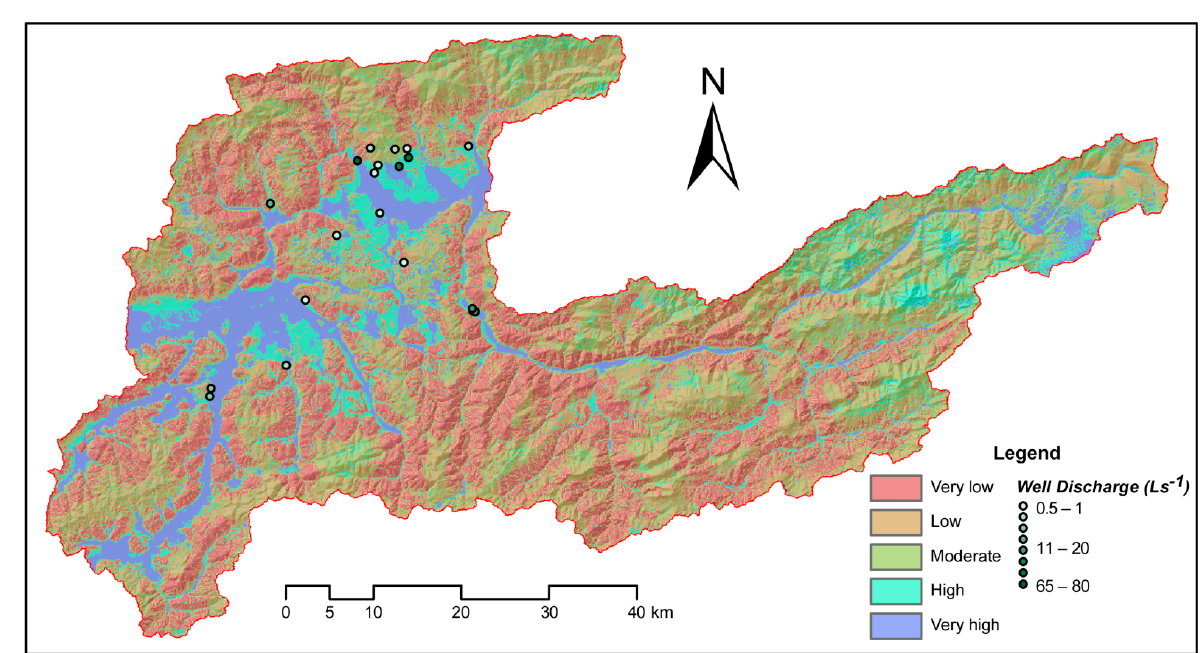
Figure 5. Groundwater potential zones (GWPZs) map of the Upper Coruh River Basin (UCRB) and well locations and their discharge amounts.